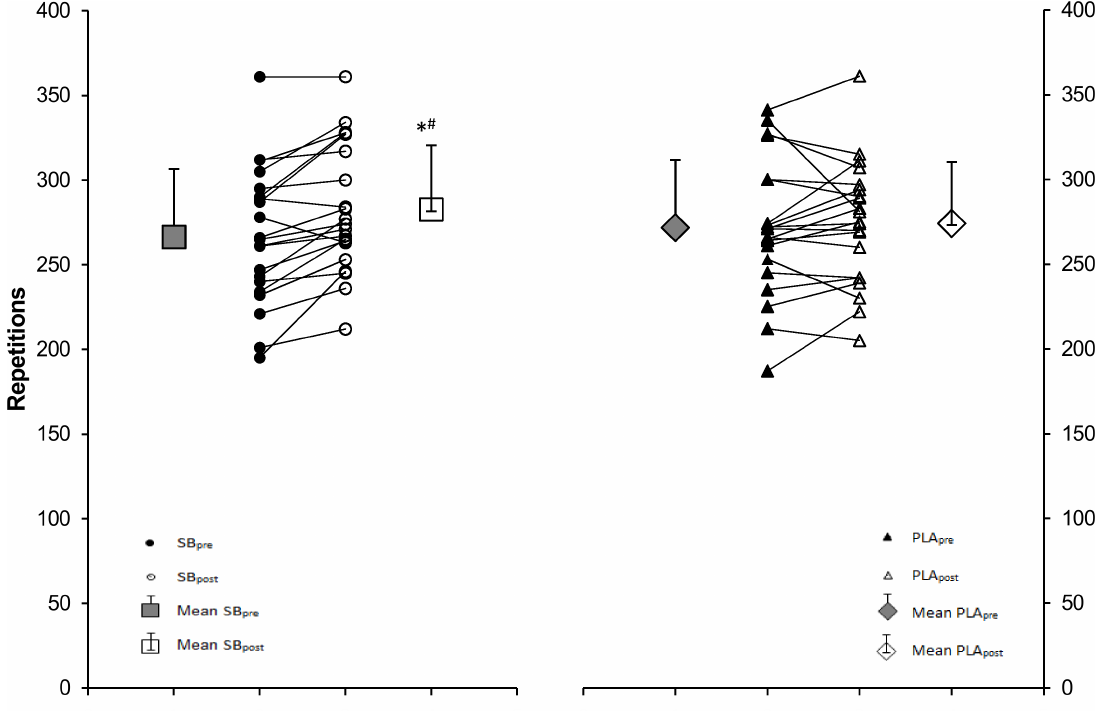
Fig 3. Total number of repetitions in all rounds of Fight Gone Bad test. SB pre , before sodium bicarbonate trial; SB post , after sodium bicarbonate trial; PLA pre , before placebo trial; PLA post , after placebo trial. Significantly different from SB pre : (cid:3) p < 0.001; significantly different from PLA post : # p =